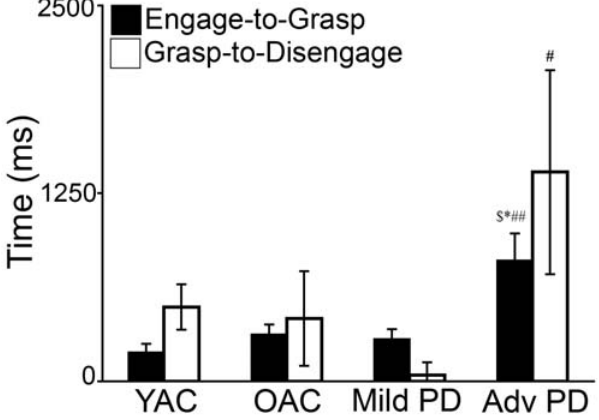
Figure 3. Time (mean and standard error) from engage to move and grasp to disengage for the four experimental groups. $ =PD . YAC; *=advanced PD . OAC; # =advanced PD . mild PD, ps ,